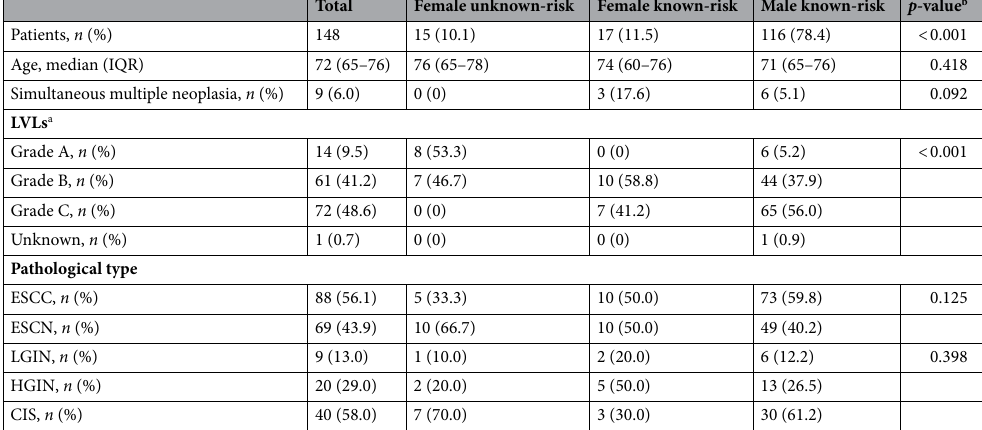
Table 2. Comparison of the selected characteristics by risk factors. After excluding the two patients whose drinking or smoking history was unknown, the patients were stratified into three groups: female unknown- risk group, female known-risk group, and male known-risk group. Values are expressed as the median (IQR) or number (%). a In one patient, the grade classification of LVLs was difficult to determine from endoscopic images. b Comparisons among the three groups were performed using the χ 2 test or ANOVA. Statistical calculations were performed using JMP 14.3.0 LVLs Lugol-voiding lesions; ESCN esophageal squamous cell neoplasia; LGIN low-grade intraepithelial neoplasia; HGIN high-grade intraepithelial neoplasia; CIS carcinoma in situ; ESCC esophageal squamous cell carcinoma; IQR interquartile range; ANOVA analysis of